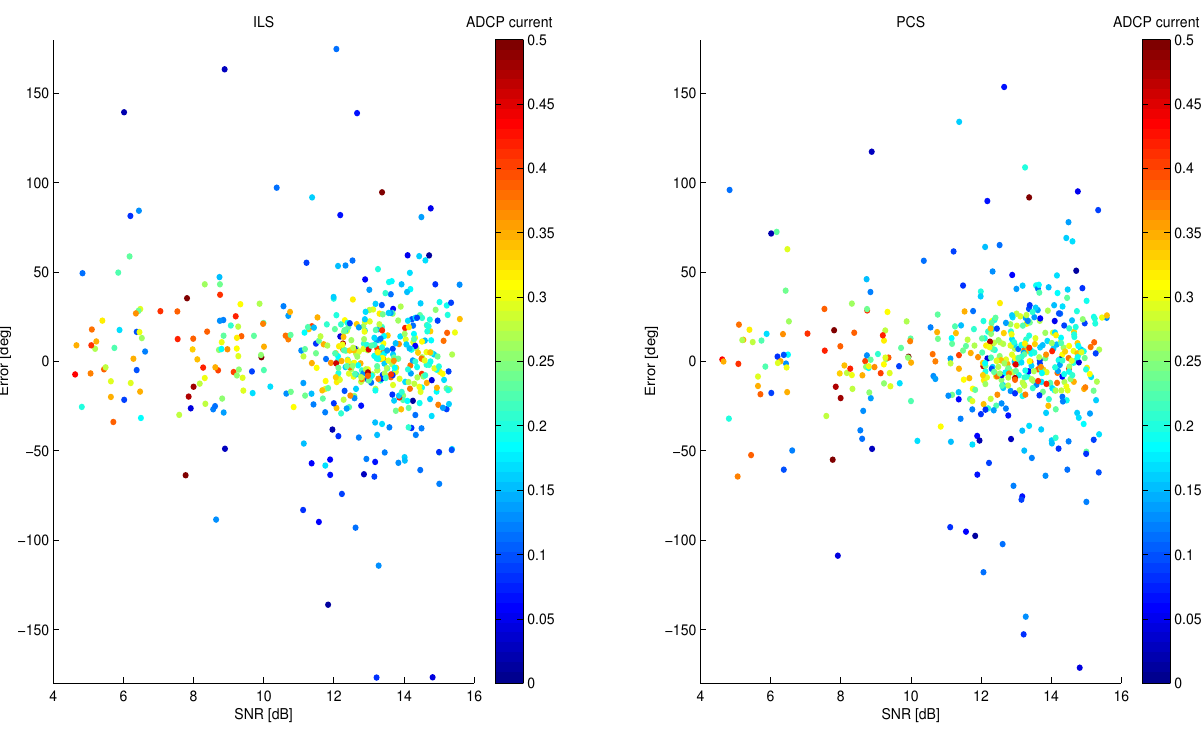
Figure 10. Dependence of current direction error on SNR for the method of ILS ( left ) and PCS ( right